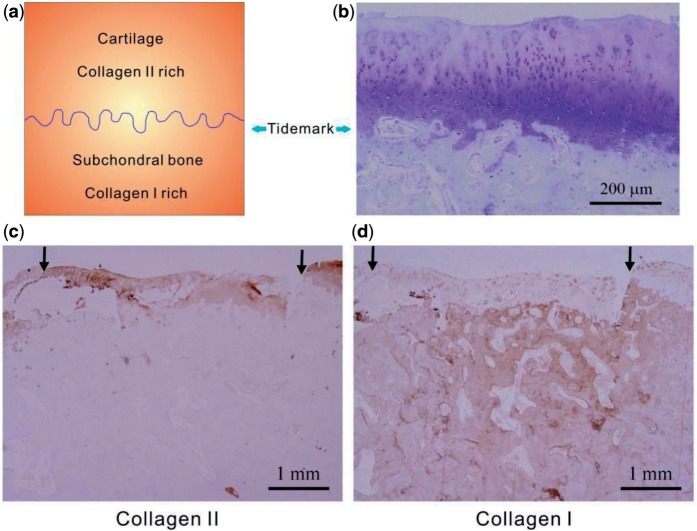
(a) Schematic presentation of the tidemark between cartilage and subchondral bone and the rich collagen types in the two regions. (b–d) Images of cross sections of reparative tissues 12 weeks after implantation of scaffold A and external BMSCs, histologically stained by toluidine blue for cartilage (b), immunohistochemically stained for collagen type II (c) and collagen type I (d). The arrows indicate the initial defect site.